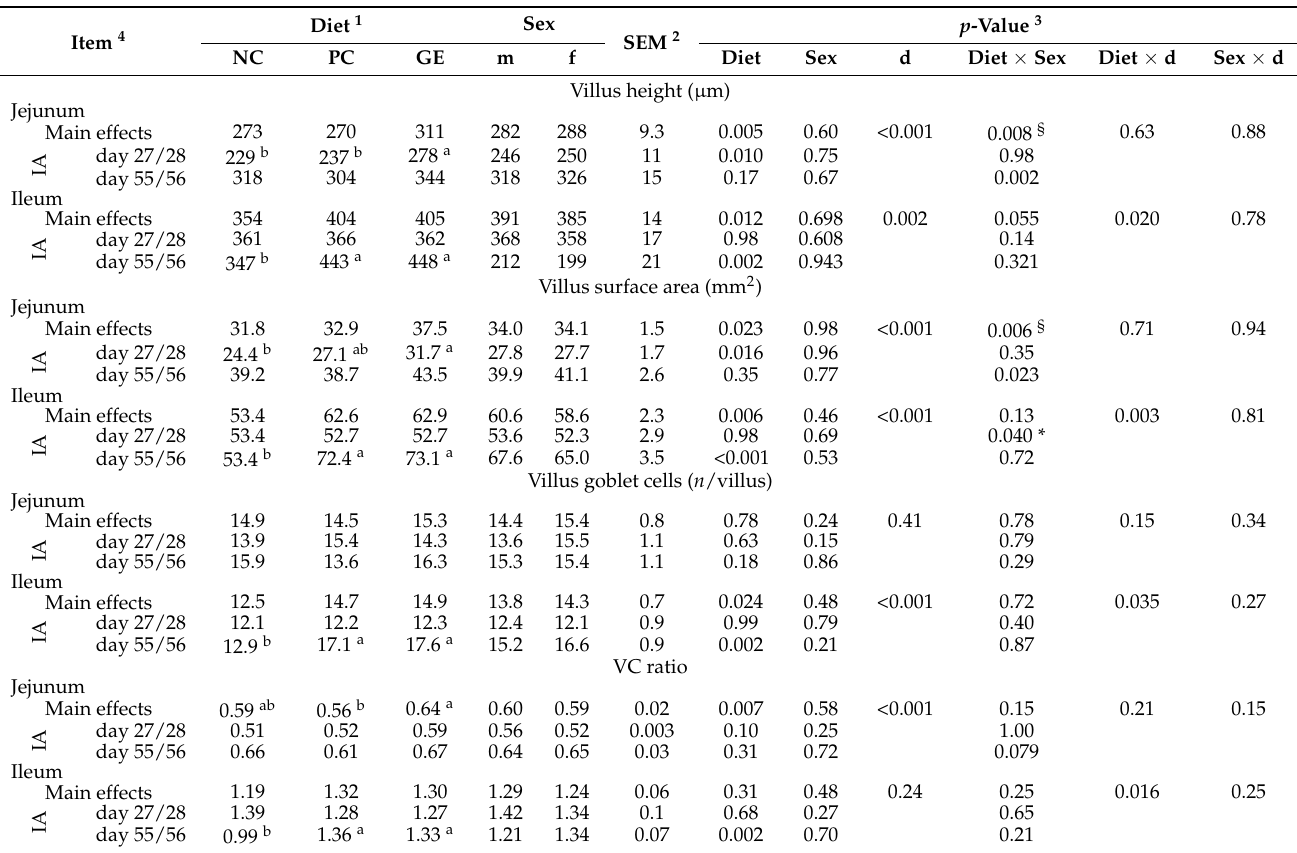
Table 2. Effect of dietary GE supplementation on intestinal villus morphology and VC ratio of weaning piglets compared to NC and